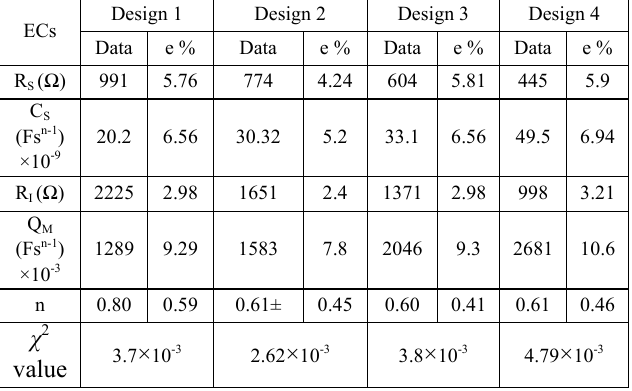
Fig. 6: Bode Plot of RBCs with its equivalent circuit. Table 4. Values of electric components of RBC for different designs with relative standard error (e